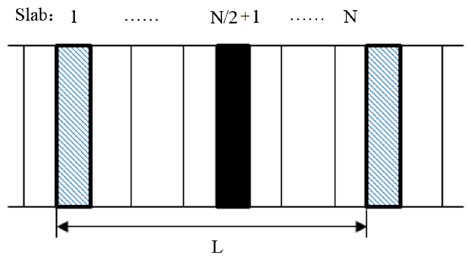
Figure 4. NEMD for calculating thermal conductivity.